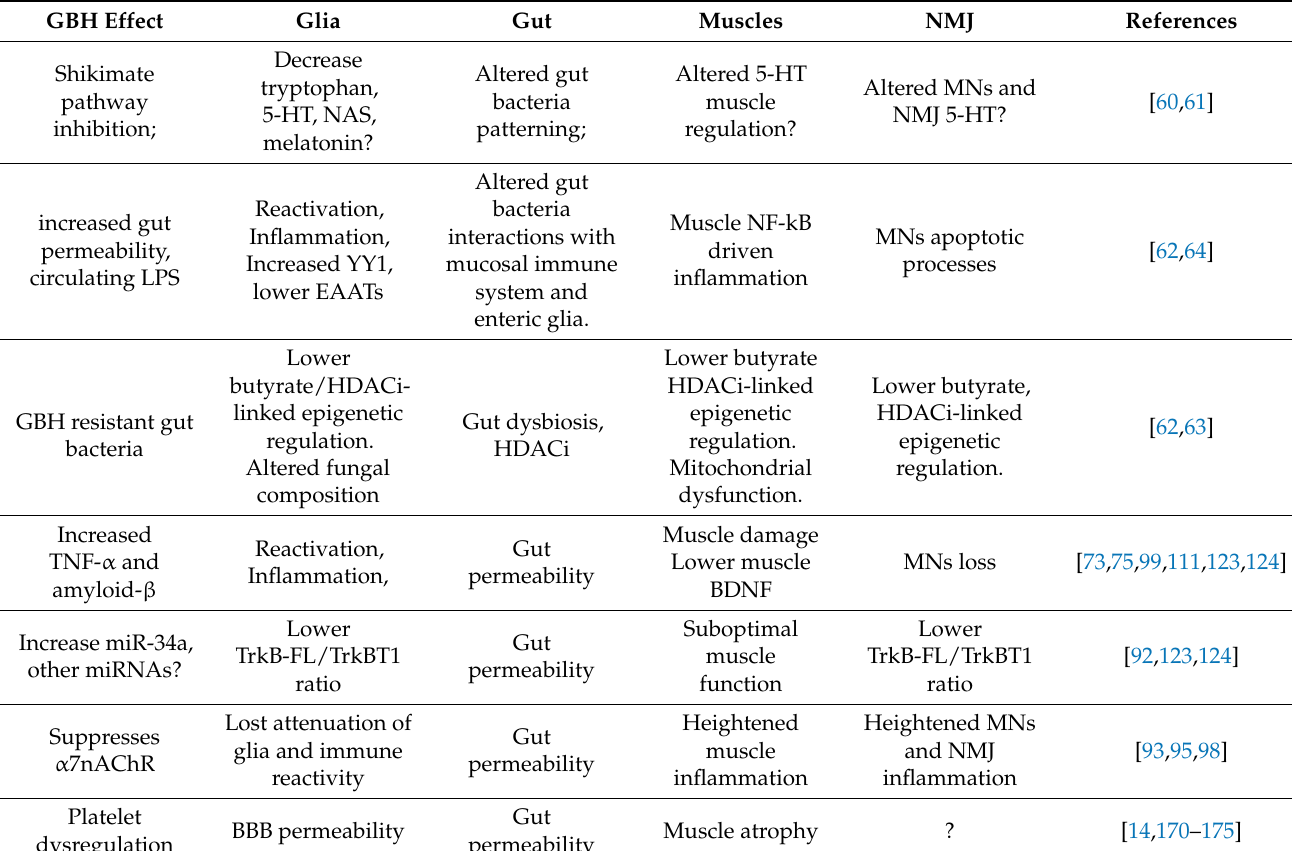
Table 1. Summarizes GBH effects in glia, gut, muscles, and NMJ, with associated references. Abbre- viations: 5-HT: 5-hydroxytryptamine (serotonin); α 7nAChR: alpha 7 nicotinic acetylcholine receptor; BDNF: brain-derived neurotrophic factor; EAAT: excitatory amino acid transporter; GBH: glyphosate- based herbicides; HDACi: histone deacetylase inhibitor; LPS: lipopolysaccharide; MNs: motor neurons; NAS: N-acetylserotonin; NF-kB: nuclear factor kappa-light-chain-enhancer of